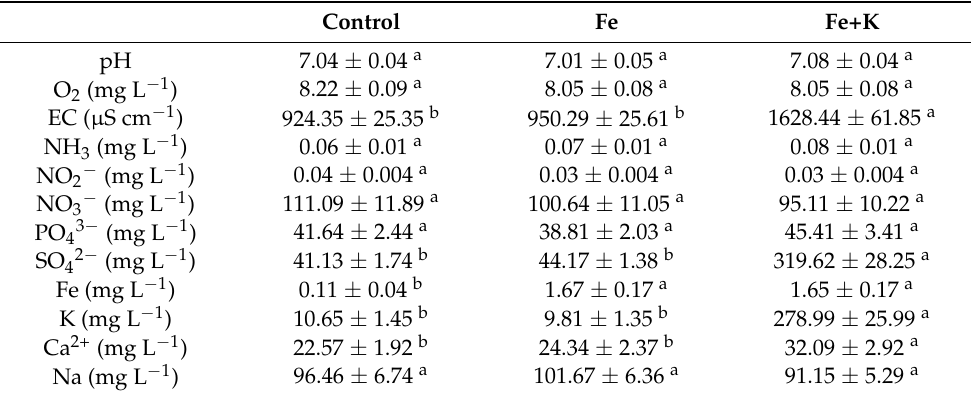
Table 2. Water physicochemical and quality parameters during the experimental period, expressed as Mean ± SEM (n = 117 for pH, n = 60 for O 2 and EC, n = 21 for NH 3 , NO 2 − , NO 3 − , PO 43 − , SO 42 − , Fe, K, Ca 2+ , Na). Different superscripts in a row denote statistically significant differences among treatments ( p < 0.05).